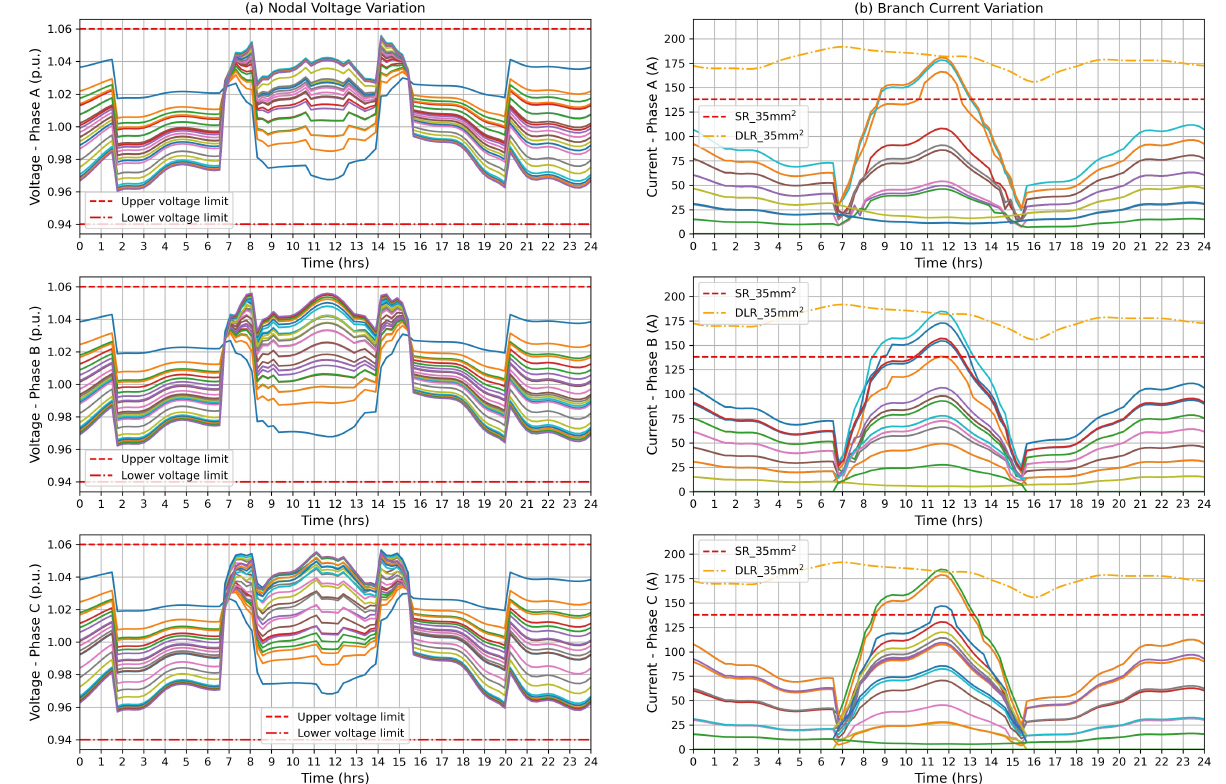
Figure 13. ( a ) Nodal voltage variation; and ( b ) branch current variation during the simulation period with DLR and OLTC voltage regulation.